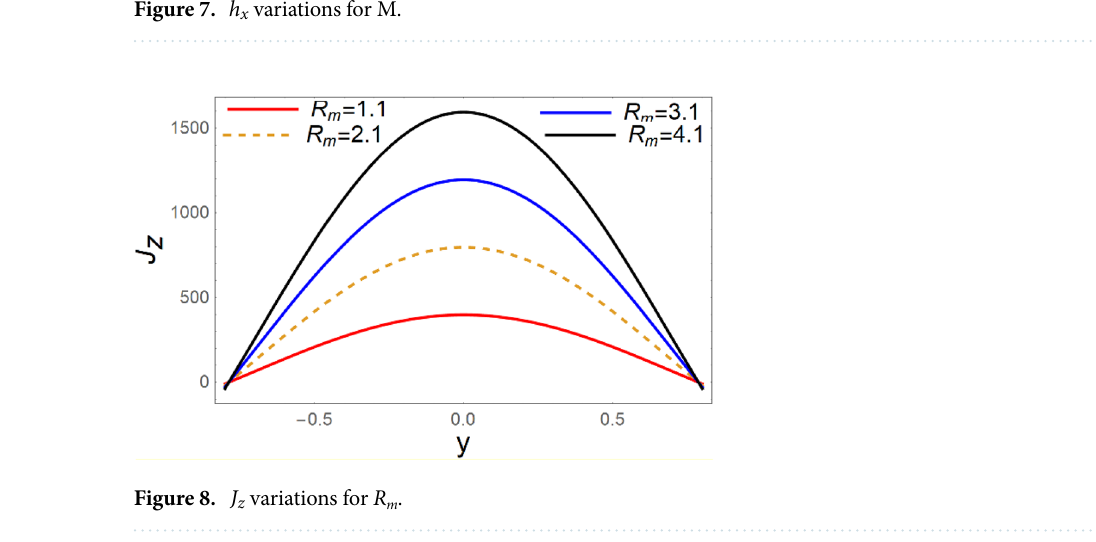
Figure 7. h x variations for M.